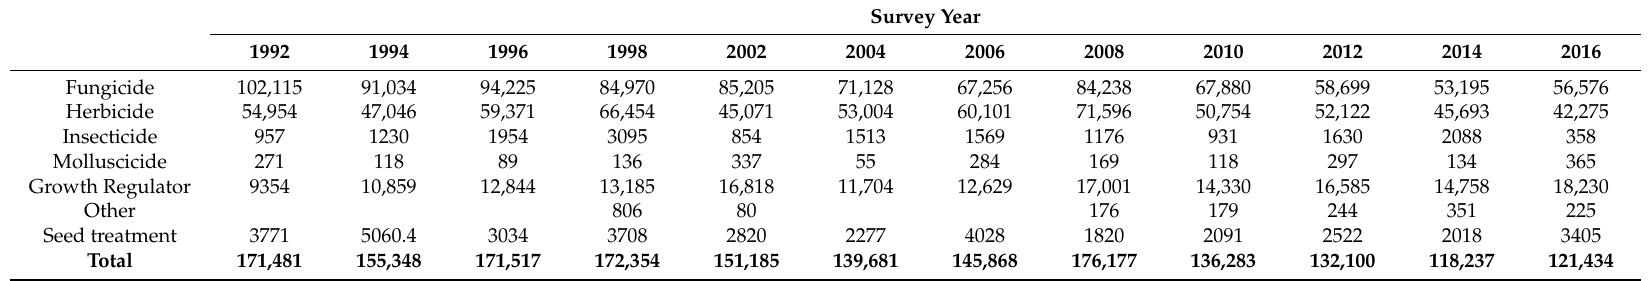
Table 3. The weight (kg) of the major pesticide groups applied to arable crops in Northern Ireland 1992–2016.